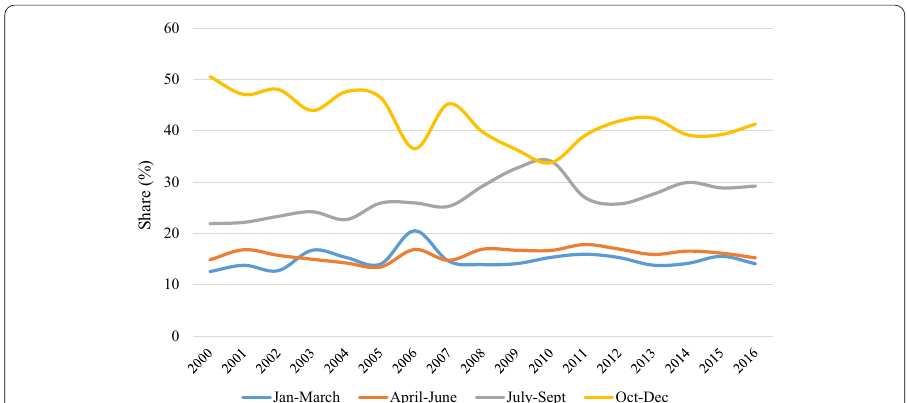
Fig. 1 Share of migrants with missing educational information by month of arrival. Variables measured